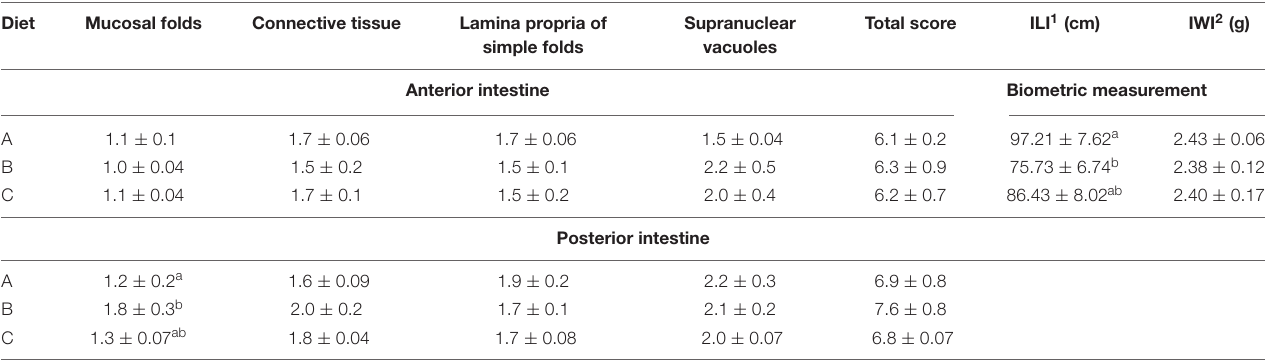
TABLE 4 | Histological scoring (for anterior and posterior intestine) and biometric measurement [intestinal length index (ILI) and intestinal weight index (IWI)] of gilthead sea bream ( Sparus aurata ) juveniles fed the control (A) and experimental (B and C) diets. Diet Mucosal folds Connective tissue Lamina propria of simple folds Anterior intestine Biometric measurement